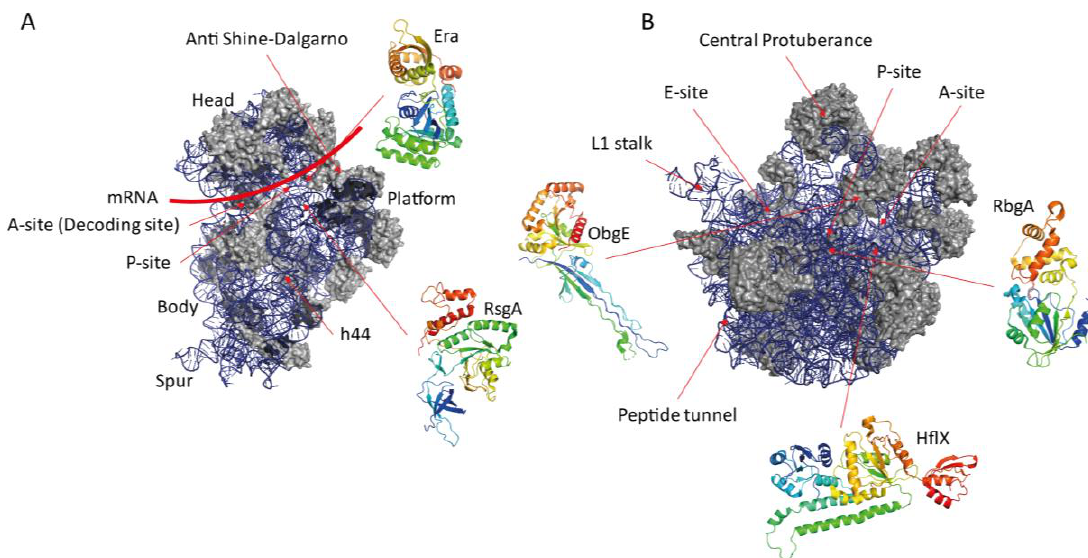
Figure 3. An overview of the ribosomal binding sites and structures of (p)ppGpp-binding RA-GTPases. ( A ) E. coli 30S ribosomal subunit (adapted from PDB-ID 4ADV [60]) with major domains and features labelled. The binding sites for RsgA and Era are indicated (structures adapted from PDB-IDs 5NO4 [56] and 3IEV [61], respectively). ( B ) E. coli 50S ribosomal subunit (adapted from PDB-ID 3J5L [62]) with major structural features including the A-, P- and E-sites labelled. The binding sites for ObgE, RbgA (not present in E. coli ) and HflX are indicated (structures adapted from PDB-IDs 5M04 [63], 3CNL [64] and 5ADY [65], respectively). R-proteins are coloured grey, whereas rRNA is coloured blue for comparison. GTPases are coloured as a gradient from the N-terminus (blue) to the C-terminus (red) and are not to scale relative to the ribosome.